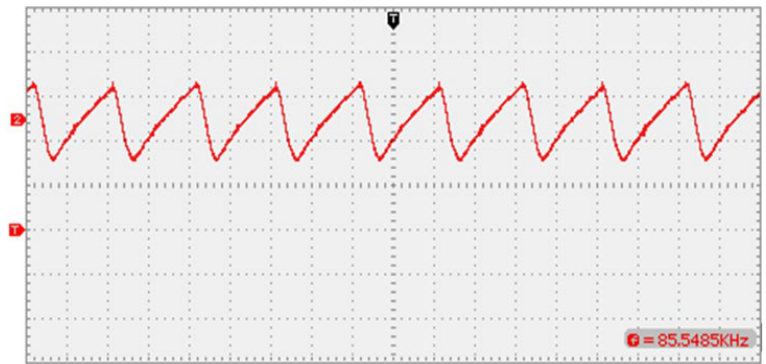
Figure 16. Inductor current I L 3 (vertical scale 500 mA/div).